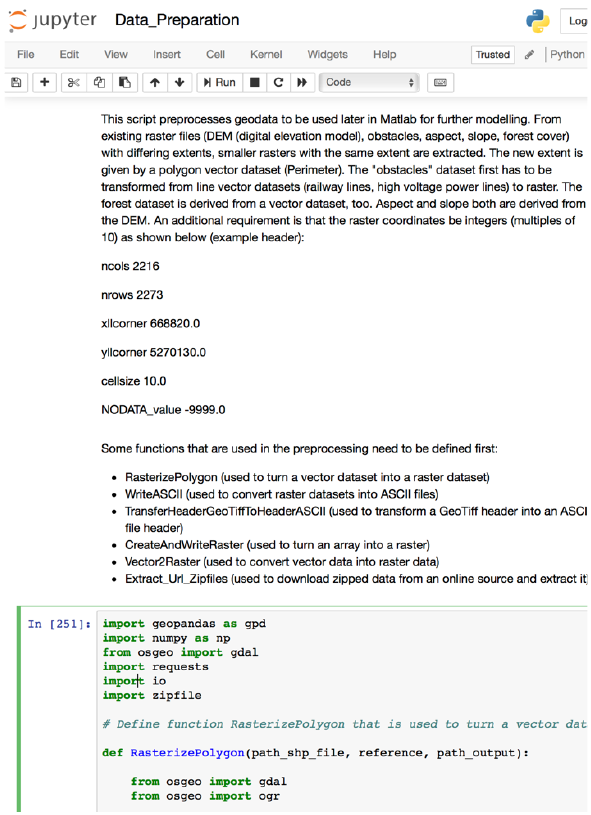
Figure 4. Example of a Jupyter notebook published in EnviDat For demonstration purposes, the notebook uses fully open vector data for railways, forests and power lines, as well as an open DEM for a small area around a sample forest range in Europe (Germany, Upper Bavaria, Kochel Forest Range, some 70 km south of München, at the edge of the Bavarian